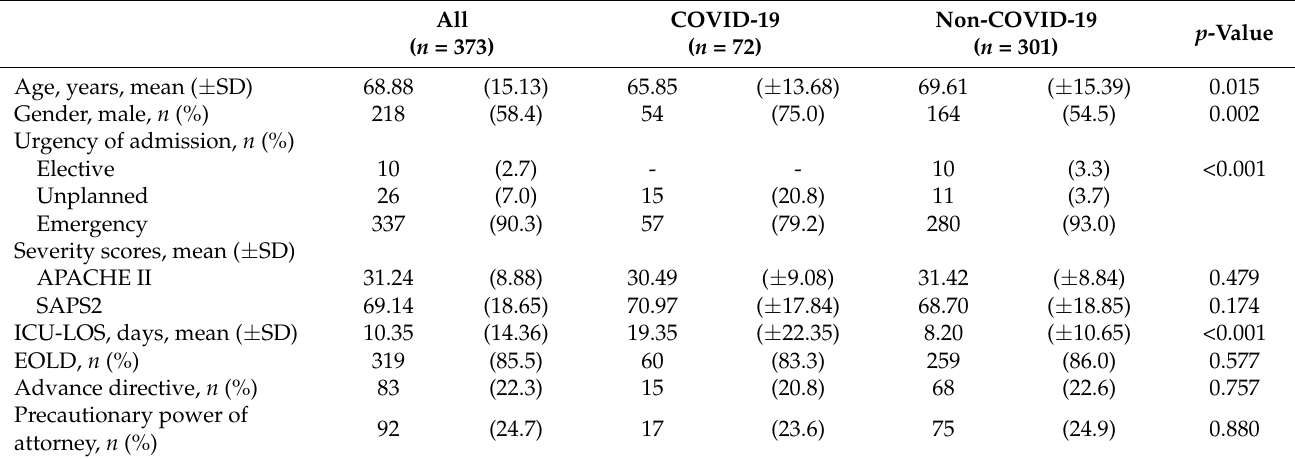
Table 1. Characteristics of all deceased patients.